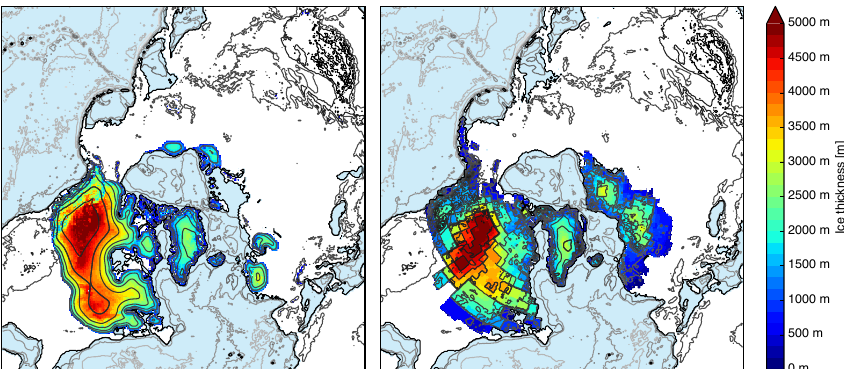
Figure 9. Simulation with the best-guess tuning parameters proximate to the mean values from Table 4 of all considered LGM bs simula- tions within the LGM ice volume range (gray horizontal bar in Fig. 7) on the left. Parameters: β =6mmPDD − 1 , E =100%, T acc =2 ◦ C, τ br =3000yr. Ice volume: − 115ms . l . e . ICE-5G from Peltier (2004) with an ice volume of 117ms . l . e . in the Northern Hemisphere on the